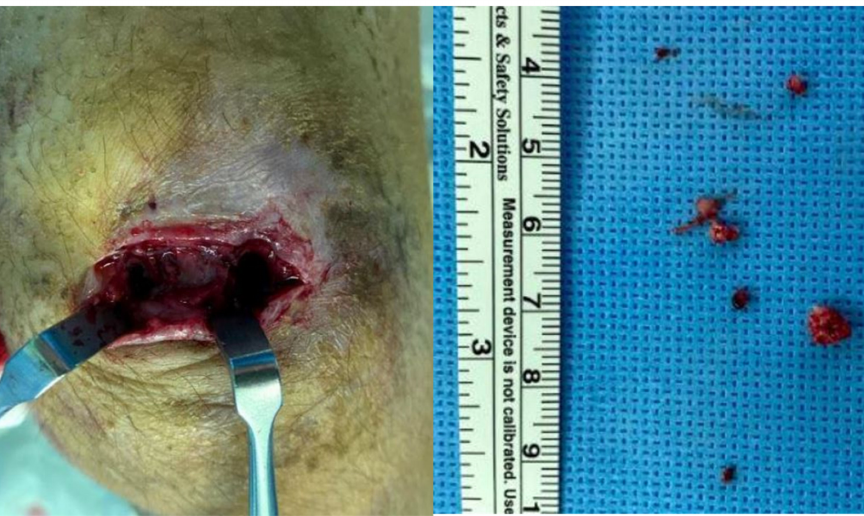
Figure 7. Intraoperative findings showed necrotic bone debris and sequestrum at the patella through medial- and lateral-sided bone defects on the anterior cortex of the